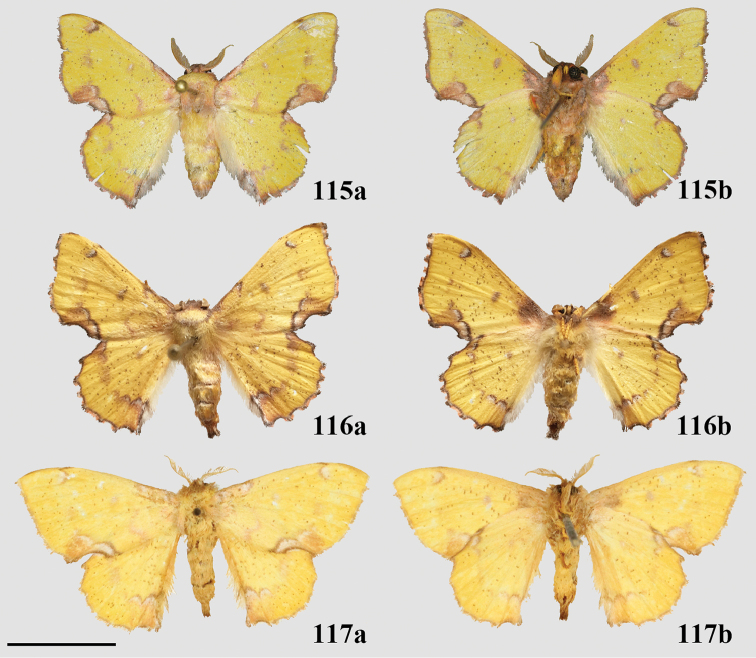
Adult specimens of Citrallaruminaa dorsal b ventral. 115 Male, Panama, Colón, Rio Indio Lodge (MGCL) 116 Female, Costa Rica, Guanacaste, Cafetal, 280 m, 90-SRNP-1981 (USNM) 117 Female, holotype, Panama, Volcán de Chiriquí, 2000–3000 ft (NHMUK). Scale bar: 1 cm.